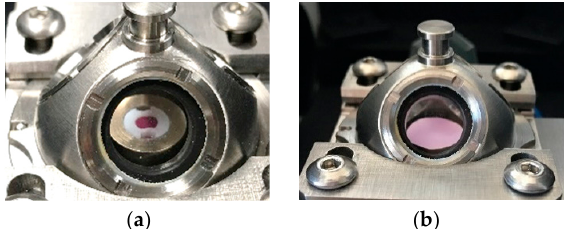
Figure 1. Pictures of the Cu-PAN samples in the gas measurement chamber dome: ( a ) Colored silica powder before gas exposure. ( b ) Cu-PAN layer printed on coated paper before gas exposure.